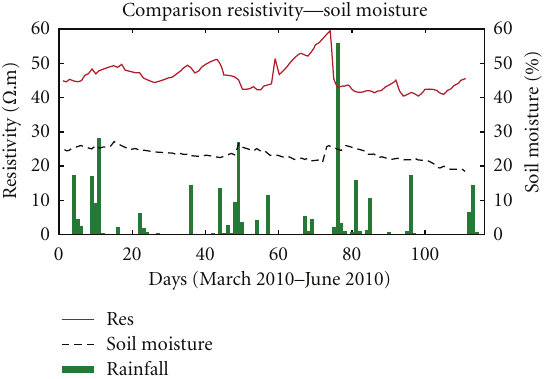
Figure 15: Comparison between Resistivity and TDR data acquired at 1m depth, in correspondence of the 35 electrode.